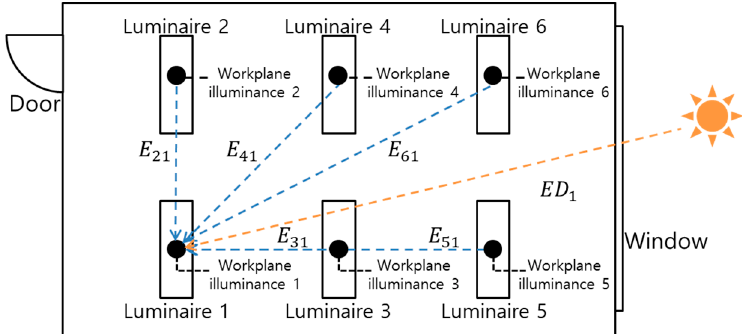
Figure 7. Calculation methods for illuminance by the nearest luminaire and the distant luminaires.